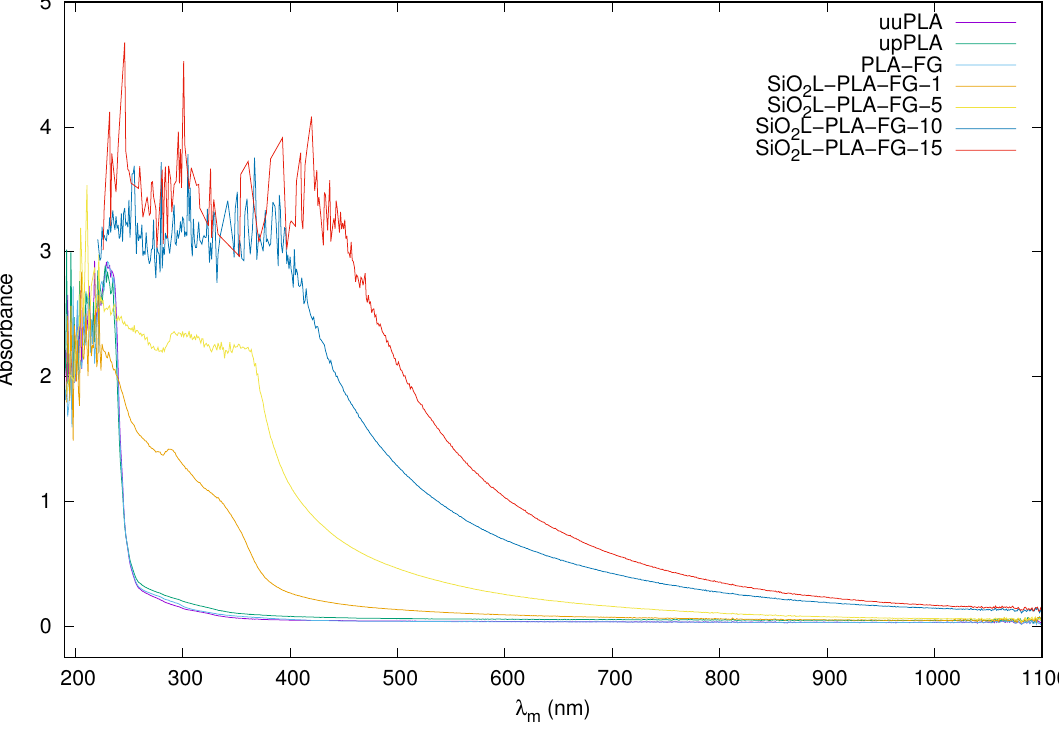
Figure 2. Absorbance spectra for SiO 2 L-PLA-FG nanocomposites.